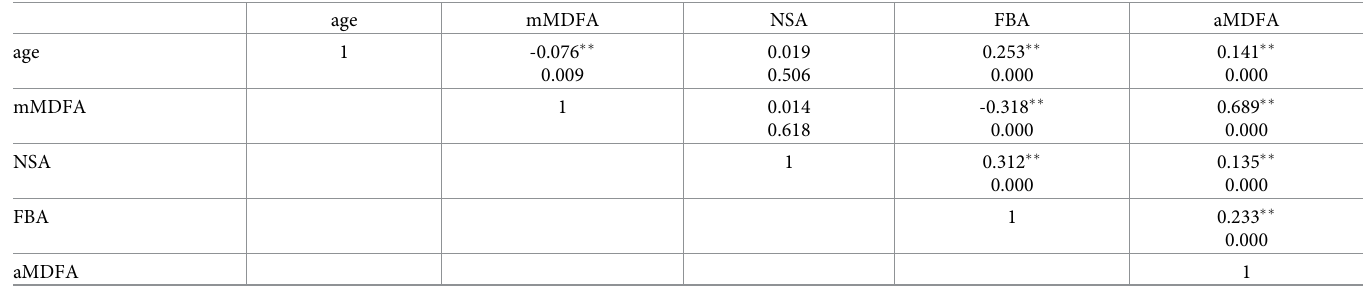
Table 4. Pearson correlation test between variables (female).